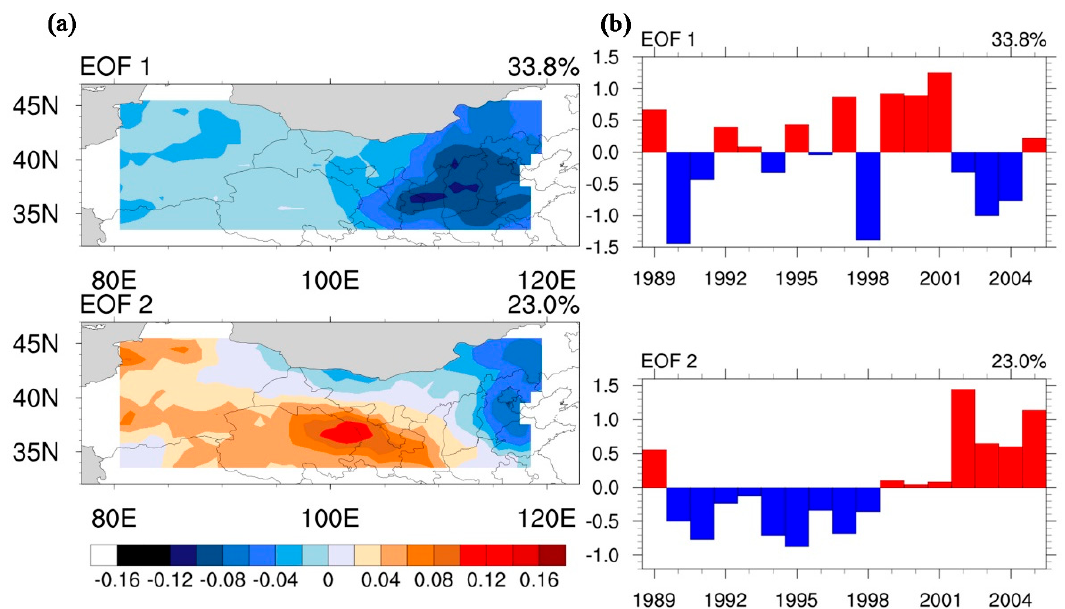
Figure 11. The spatial distributions ( a ) and principal components ( b ) of the first two modes in the water-control region. The numbers in the upper right corner of the figure represent the explanatory variance in the first modes.